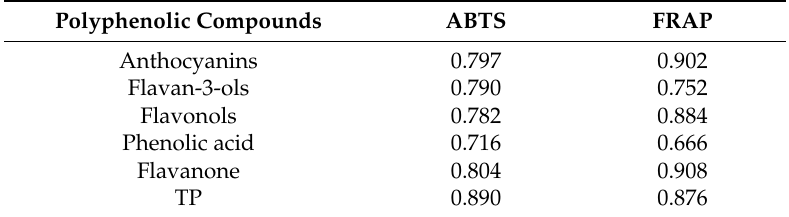
Table 5. Correlation matrix between polyphenolic compounds and the key antioxidant activity method of chokeberry and its